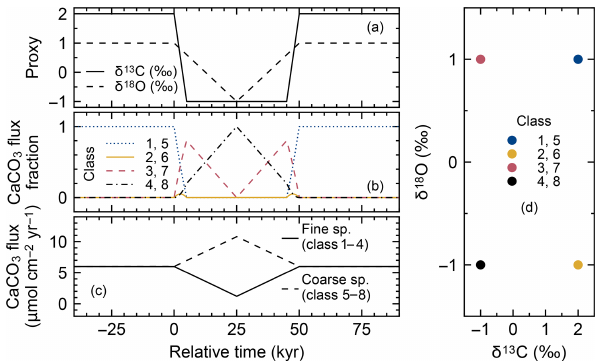
Figure 14. Timelines of proxy inputs (a) , normalized rain fluxes of individual classes of CaCO 3 particles (b) with different proxy values (d) and total rain fluxes of fine- and coarse-sized CaCO 3 species (c) in simulations examining the effect of species-specific mixing/dissolution properties. In panel (b) , rain fluxes of individual classes of fine and coarse CaCO 3 species are normalized against the total rain fluxes of respective fine and coarse CaCO 3 species from panel (c)